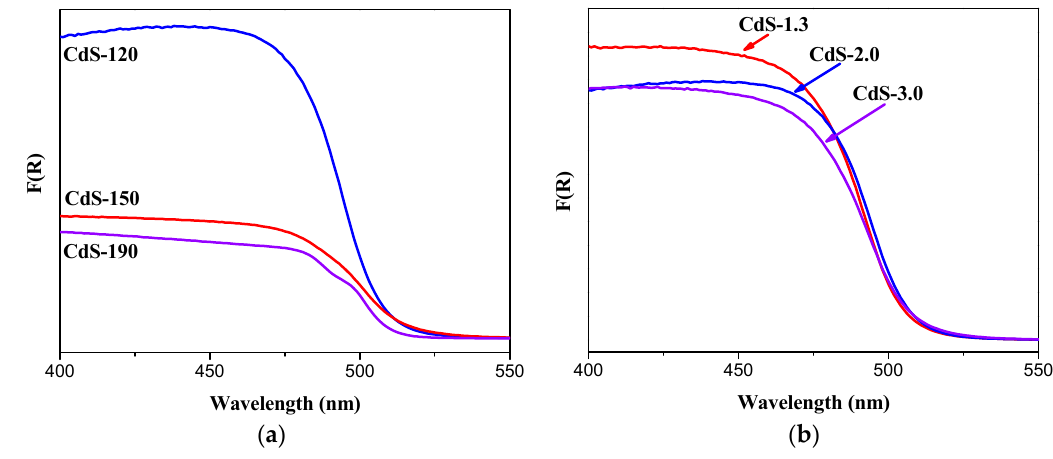
Figure 7. UV-vis spectra of CdS samples: ( a ) influence of solvothermal temperature (CdS-120, 150 and 190); ( b ) influence of H 2 O/thiourea ratio (CdS-1.3, 2.0 and 3.0).